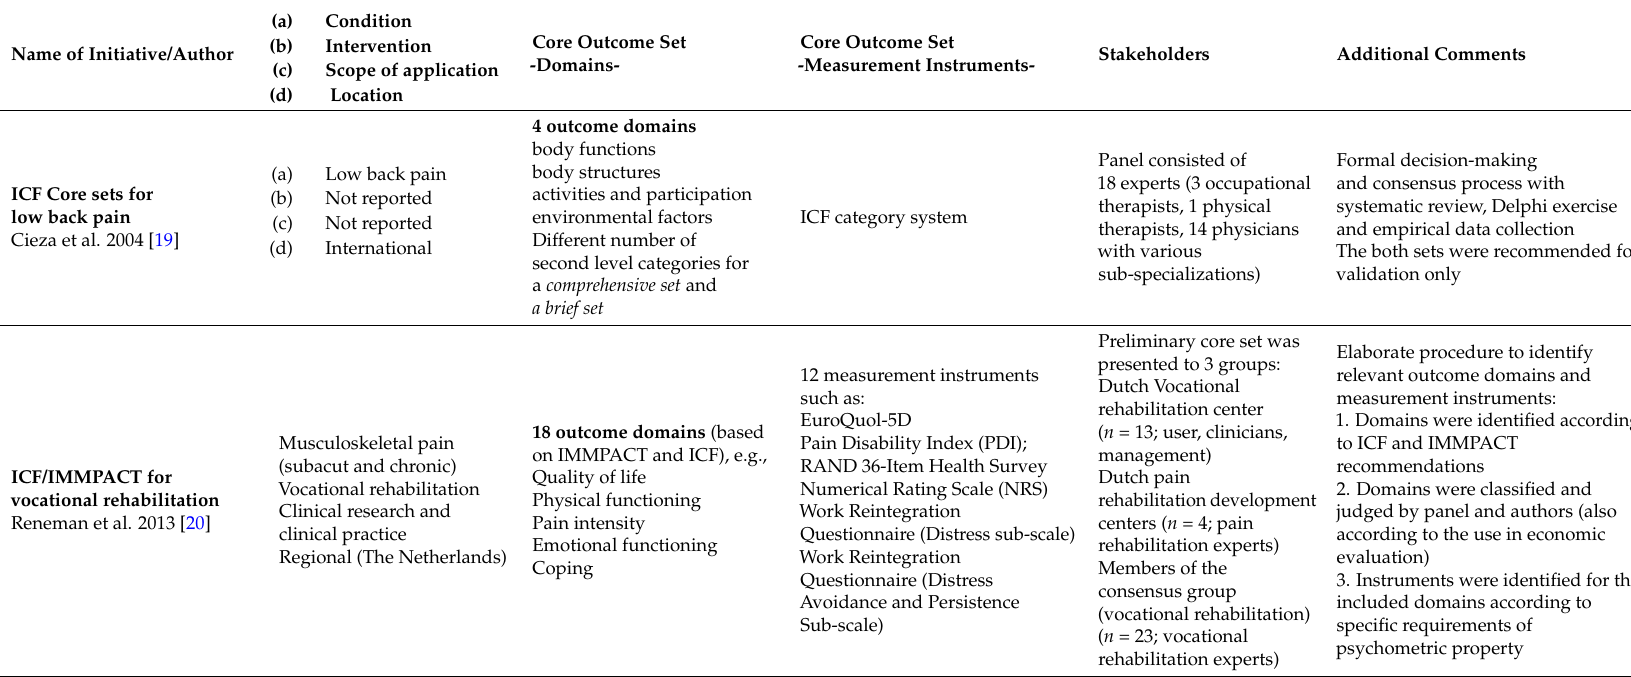
Table 1. Recommendations for core outcome sets for clinical trial and/or effectiveness studies in chronic pain and back pain (table modified and adapted from Deckert et al. [25]).